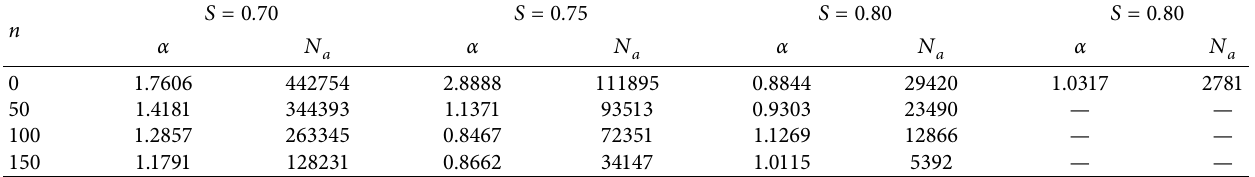
Table 8: Estimated two-parameter Weibull distribution parameters of the flexural fatigue life of